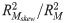
Number of neurons and conditions required for statistically significant rotations.The CMPT was carried out (500 repetitions) for many subsets of example PMd/M1 data including from 10–120 neurons and 2–20 conditions. (a) Map of p-values for the rotational goodness-of-fit ratio (RGR: RMskew2/RM2). (b) Map of effect size (difference between observed RGR and mean of permuted distribution, divided by the SD of the permuted distribution). For every permutation, random neurons and conditions were drawn from the example set. Contours show the 0.05 and 0.01 significance levels.